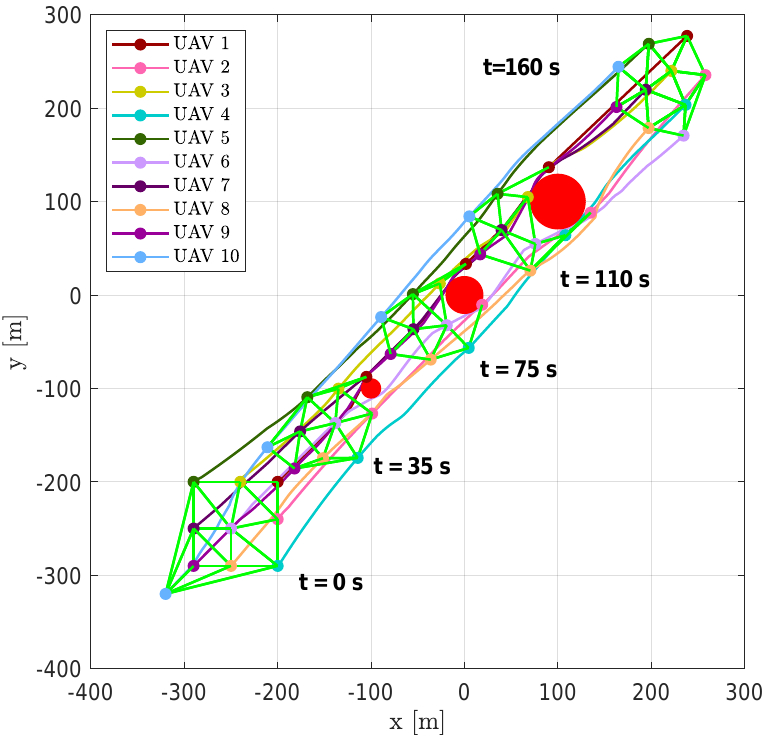
Figure 15. Scenario #1—10 aircraft: UAV trajectories. Red circles represent obstacles; colored markers indicate positions at different time instants; green straight lines highlight DTG